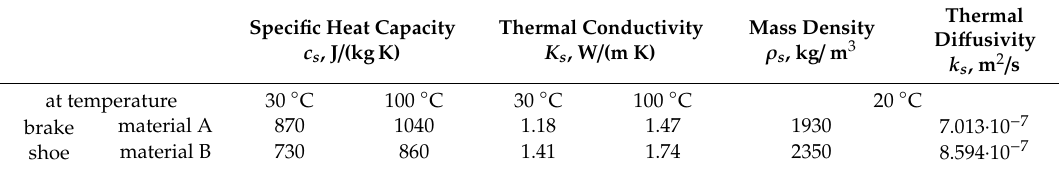
Table 4. Properties of the brake shoe materials [31].